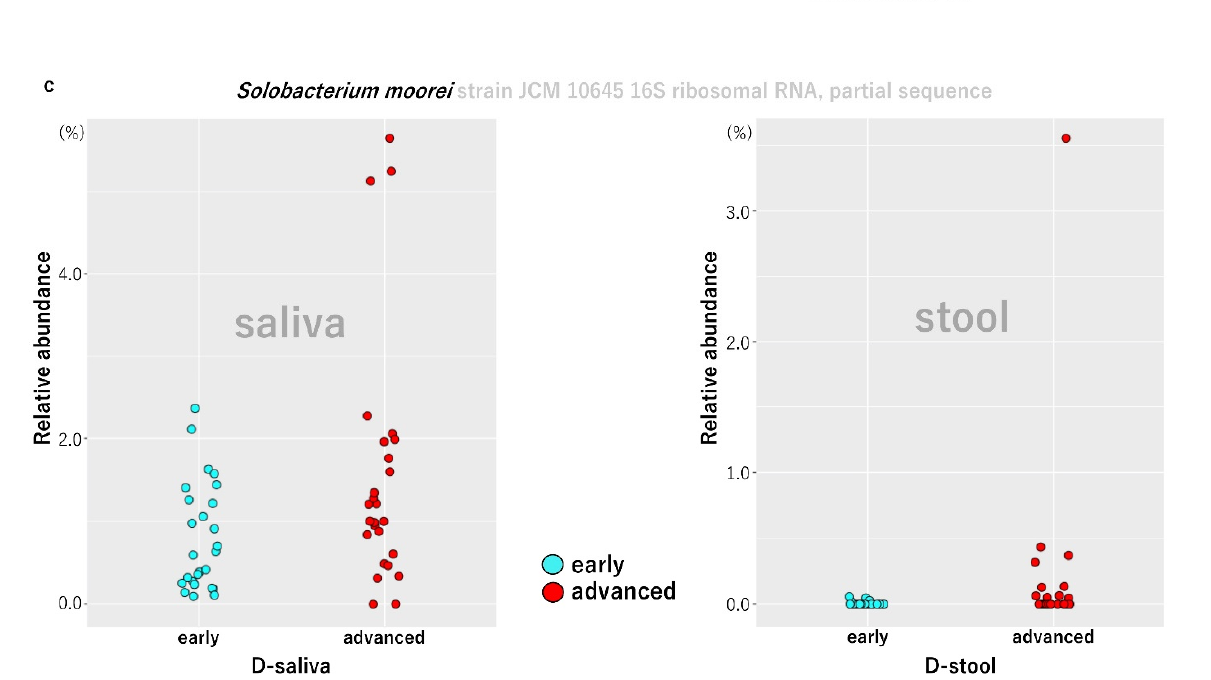
Figure 4. Linear discriminant analysis effect size (LEfSe) comparing bacterial group abundances between “early-stage disêse” (Stage Ⅰ , Ⅱ ) and “advanced-stage disease” (Stage Ⅲ , Ⅳ ) in ( a ) saliva of patients (D-saliva) and ( b ) stool of patients (D-stool). ( c ) The relative abundance of Solobacterium moorei in D-saliva and D-stool was statistically significant in patients with advanced-stage CRC compared to that in patients with early-stage CRC.